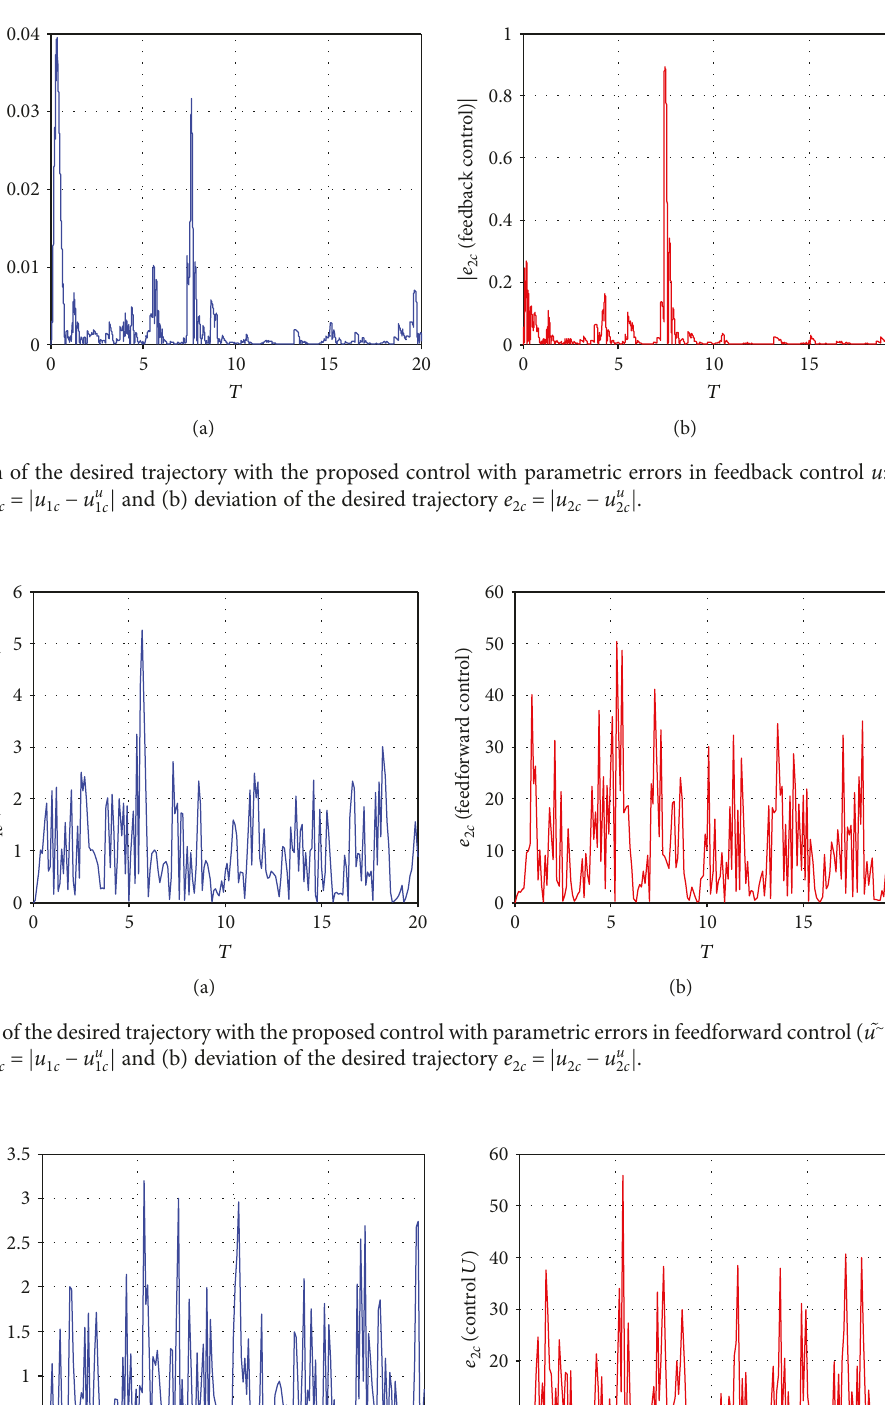
= x − x u 1 c 1 c and (b) deviation of the desired trajectory e 2 c c